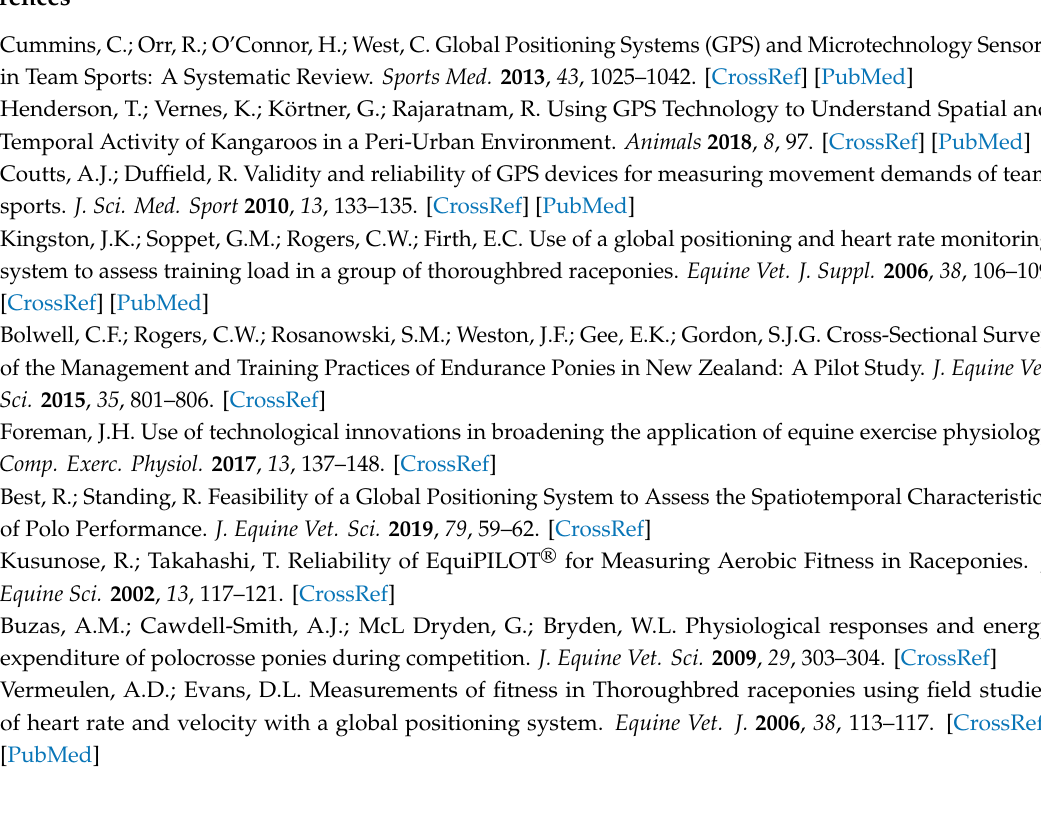
Table S1: E ff ect sizes ± 90 confidence intervals for mean distance (m) per chukka, compared at each level of play. Table S2: E ff ect sizes ± 90 % confidence intervals for mean time (min:s) in speed zone per chukka, compared at each level of play. Table S3: E ff ect sizes ± 90 % confidence intervals for mean high-intensity activities per chukka, compared at each level of